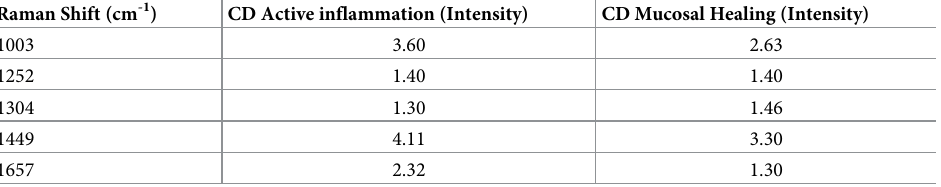
Table 3. Relative intensity of Raman shifts between CD healing vs non-healing taken from